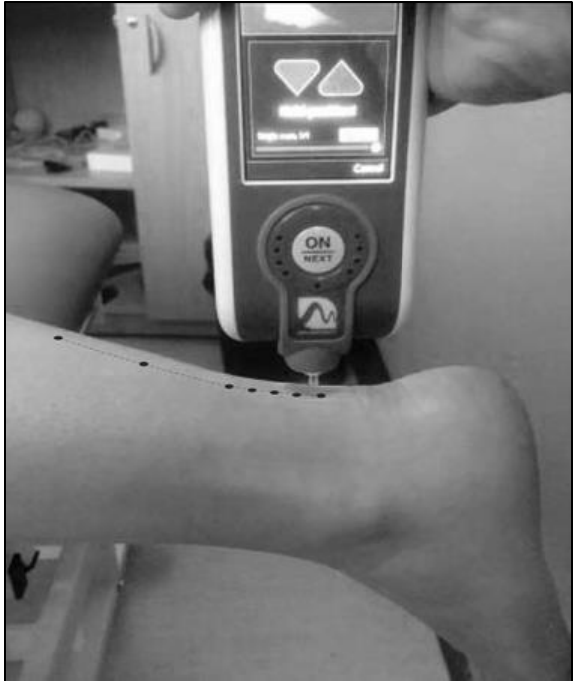
Figure 1. Gastrocnemius – Achilles tendon unit (GAT) stiffness measurement at 8, 9, 10, 11, 12, 16, and 20 cm from the plantar aspect of the heel. Note that the participant is in a prone position with the knees extended and feet hanging barefoot and unsupported from the edge of the table.